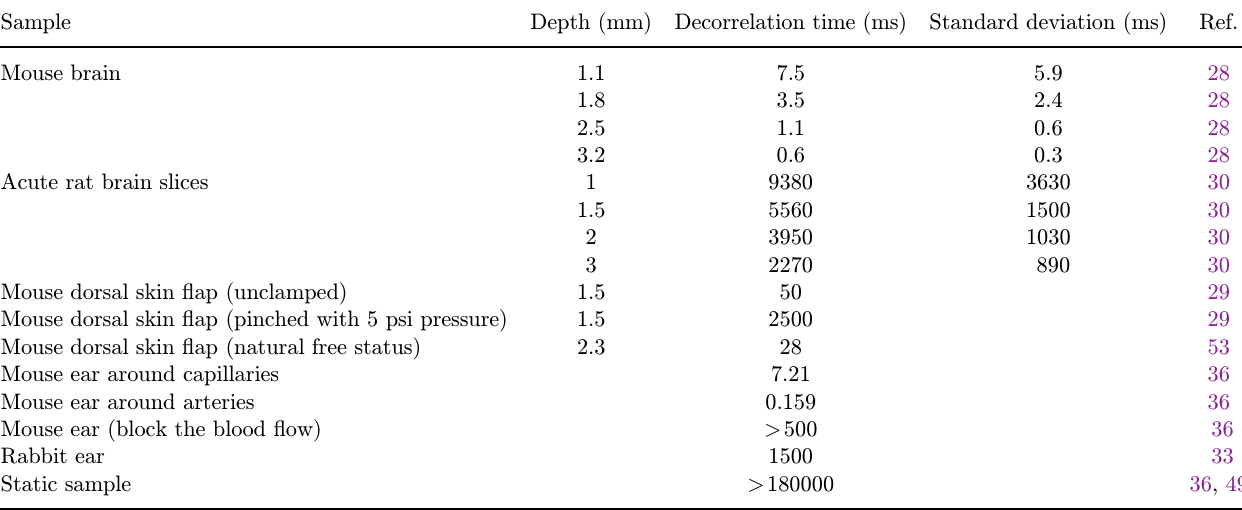
Table 1. Decorrelation time of some typical scattering media.